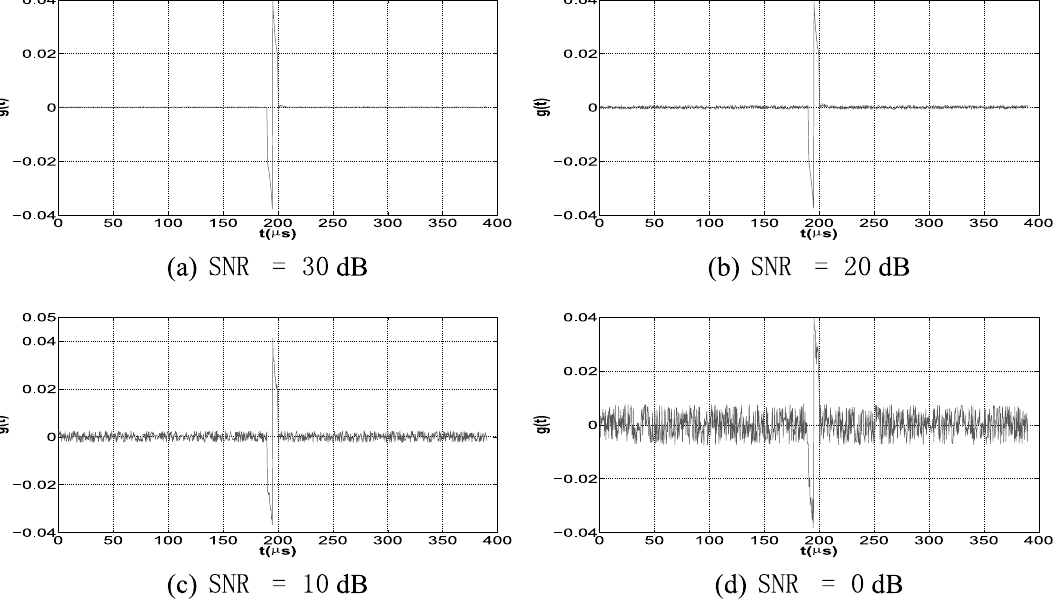
Fig. 9. Impulse responses for Case 1, with a = 25 mm and d = 5 mm, with different levels of SNR.